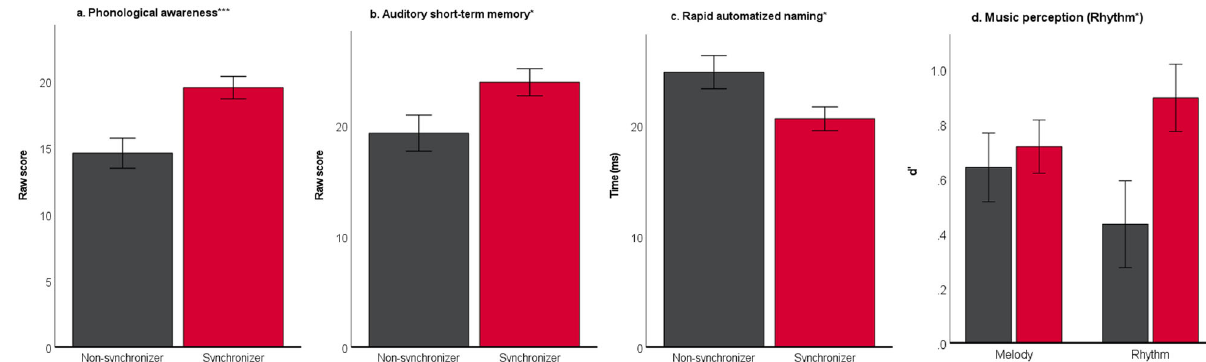
Fig. 1 Synchronizers (red) perform better than Non-synchronizers (dark gray) on all preliteracy skill tasks. One-way ANOVAs were used to compare mean performances between the two synchronization groups, Non-synchronizers, and Synchronizers, on preliteracy tasks of ( a ) phonological awareness ( F = 11.680, p < 0.001, η p 2 = 0.175), ( b ) auditory short-term memory ( F = 4.773, p = 0.031, η p 2 = 0.050), ( c ) rapid automatized naming of objects and colors ( F = 4.881, p = 0.030, η p 2 = 0.053), and ( d ) music perception (signi fi cant difference was found for the rhythm subtest ( F = 5.083, p = 0.027, η p 2 = 0.052), but not for the melody subtest. Signi fi cant differences reveal Synchronizers scoring higher on all of the tasks than Non-synchronizers. (* p < 0.05, ** p < 0.01, *** p < 0.005; Error bars at ± 1 standard